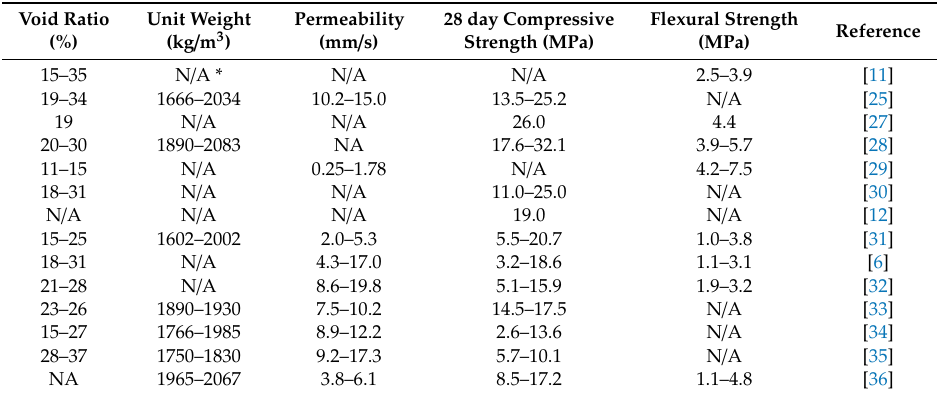
Table 1. Properties of pervious